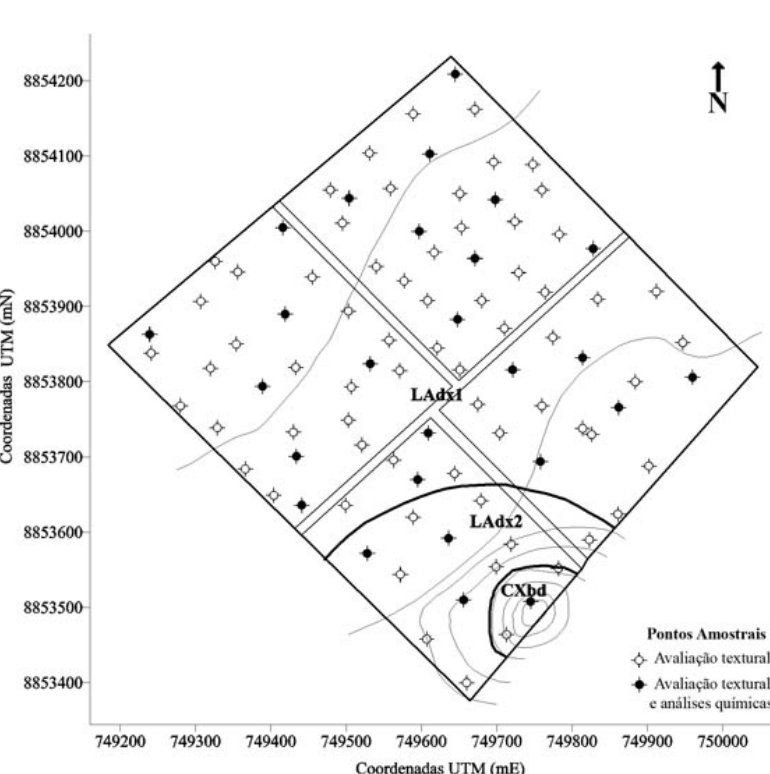
Figura 1. Mapa de solos das parcelas experimentais e pontos amostrais da PI coco, Frutese, Platô de Neópolis, SE. Legenda: LAdx1: Latossolo Amarelo Distrocoeso argissólico A moderado textura média cerrado/ floresta tropical subcaducifólia relevo plano (0–1 cm m -1 de declividade) epieutrófico; LAdx2: Latossolo Amarelo Distrocoeso argissólico A moderado textura média/argilosa cerrado/floresta tropical subcaducifólia relevo plano (0–1 cm m -1 de declividade) epieutrófico; CXbd: Cambissolo Háplico Tb distrófico gleissólico A moderado textura média/argilosa cerrado/floresta tropical subcaducifólia relevo plano a suave ondulado (1-4 cm m -1 de declividade) epieutrófico,